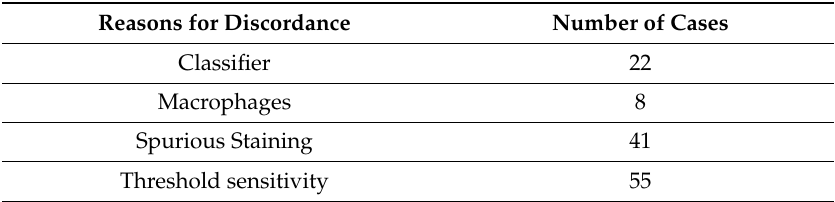
Table 1. Reasons for